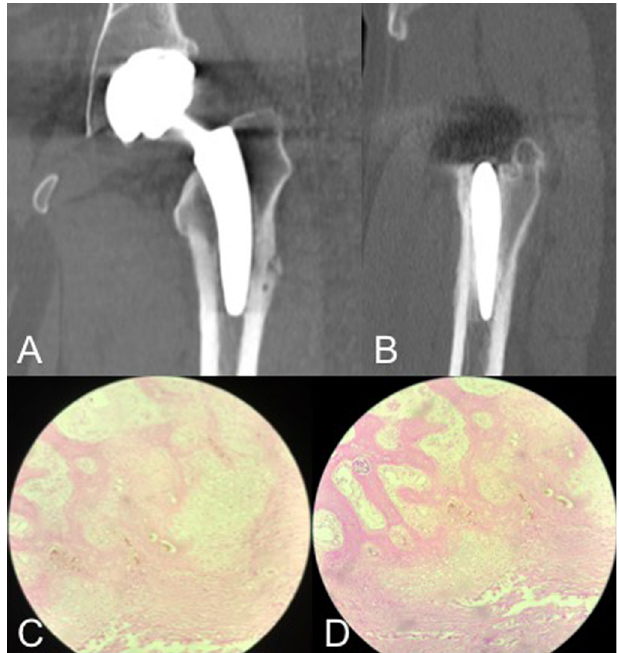
Figure 4. A and B. Coronal and sagittal computed tomography slices obtained at the time of bone biopsy, taken from the lateral femoral cortical at 9 months of follow-up depicting no evidence of stem loosening or sinking. C and D. 10x and 40x haematoxylin and eosin staining histological sections from the same biopsy. Pathology analysis reveals disorganized trabecular bone and cartilaginous tissue with peri-haversian bone formation areas and abundant capillaries (angiogenesis), as well as increased subperiosteal osteoblastic activity.